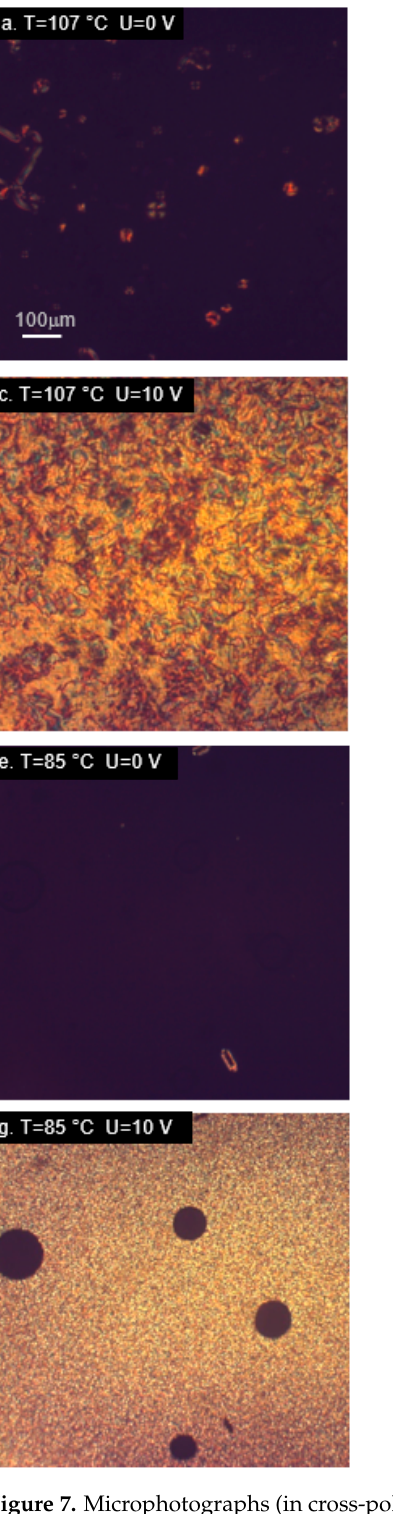
Figure 6. Microphotographs (in cross-polarized light) of compound AU12 in nematic ( a , b ) and smectic phase ( c , d ), showing alignment changes due to electric field. Sample placed in cell with omeotropically-ordering layer.